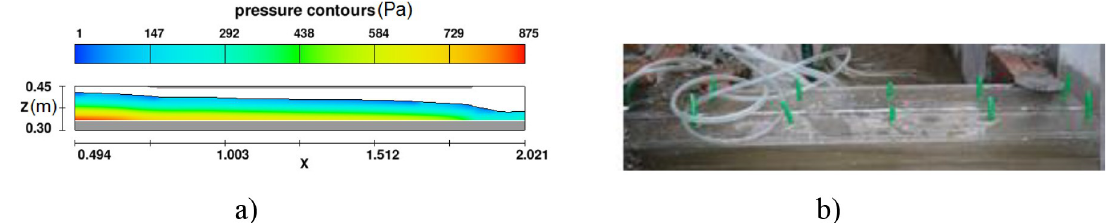
Fig 6. Flow regimes in a boxed culvert in Run 1. a) Numerical model; b) Physical model.